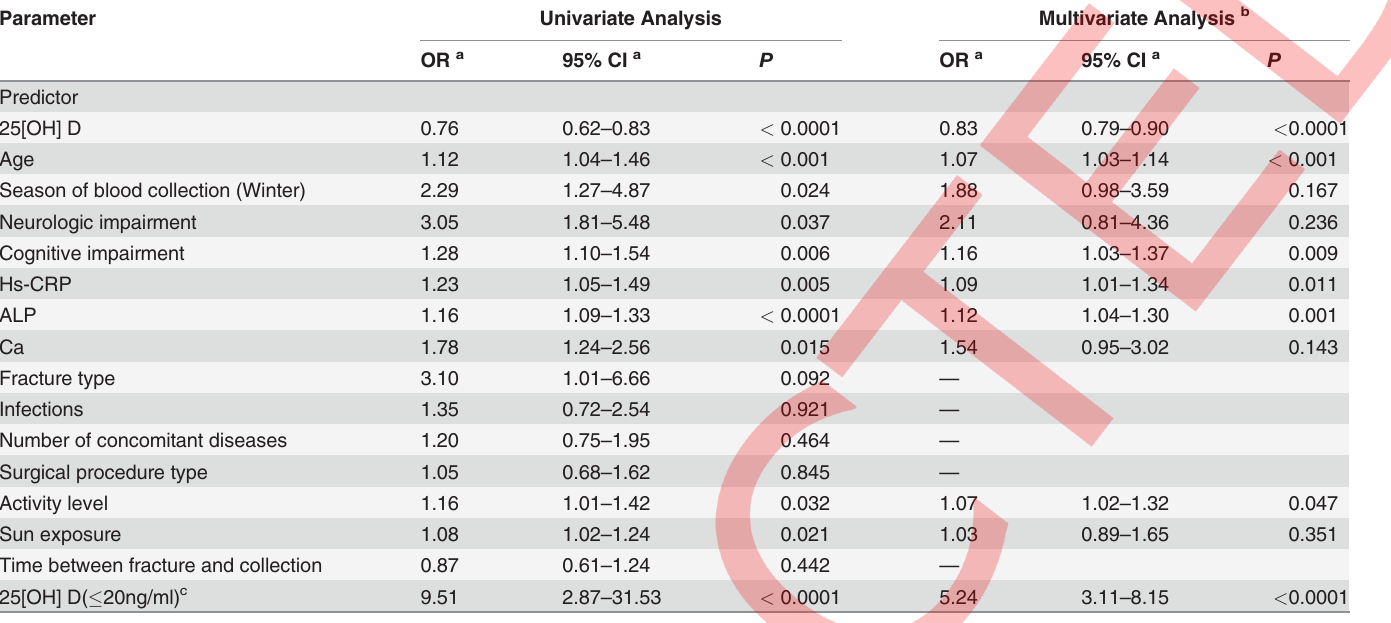
Table 2. Univariate and multivariate logistic regression analysis for functional